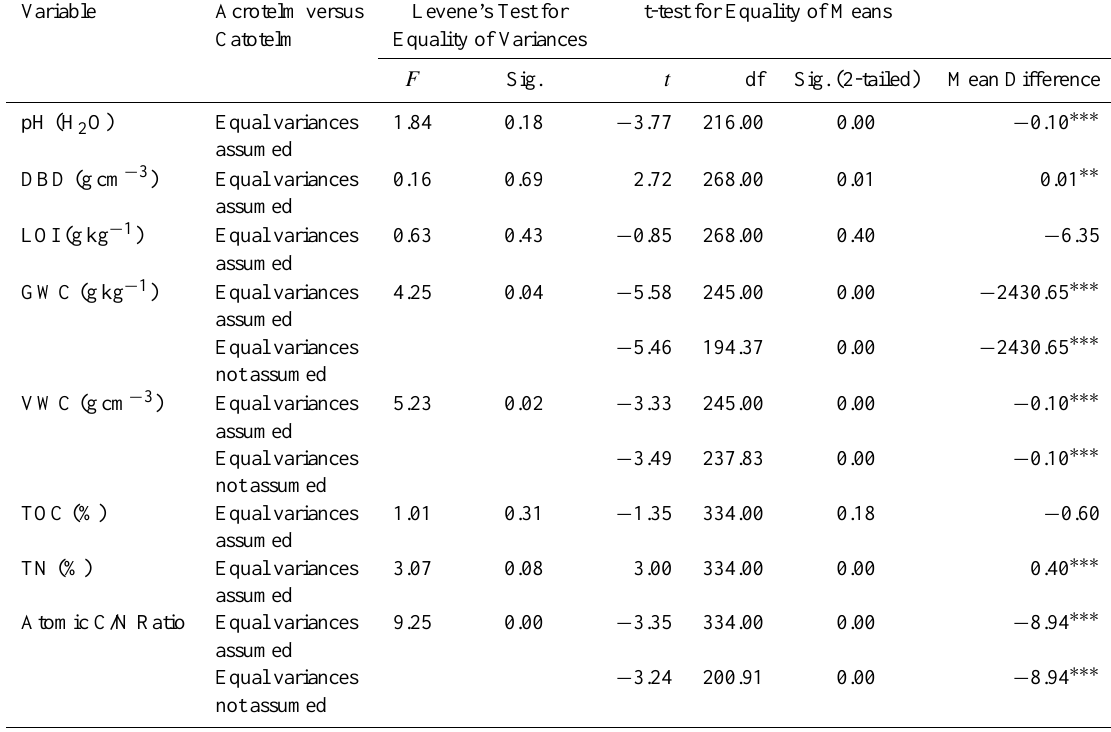
Table 7a. Results of Independent t-tests for Acrotelm versus Catotelm (a) and Inland versus Coastal Peats (b). Variable Acrotelm